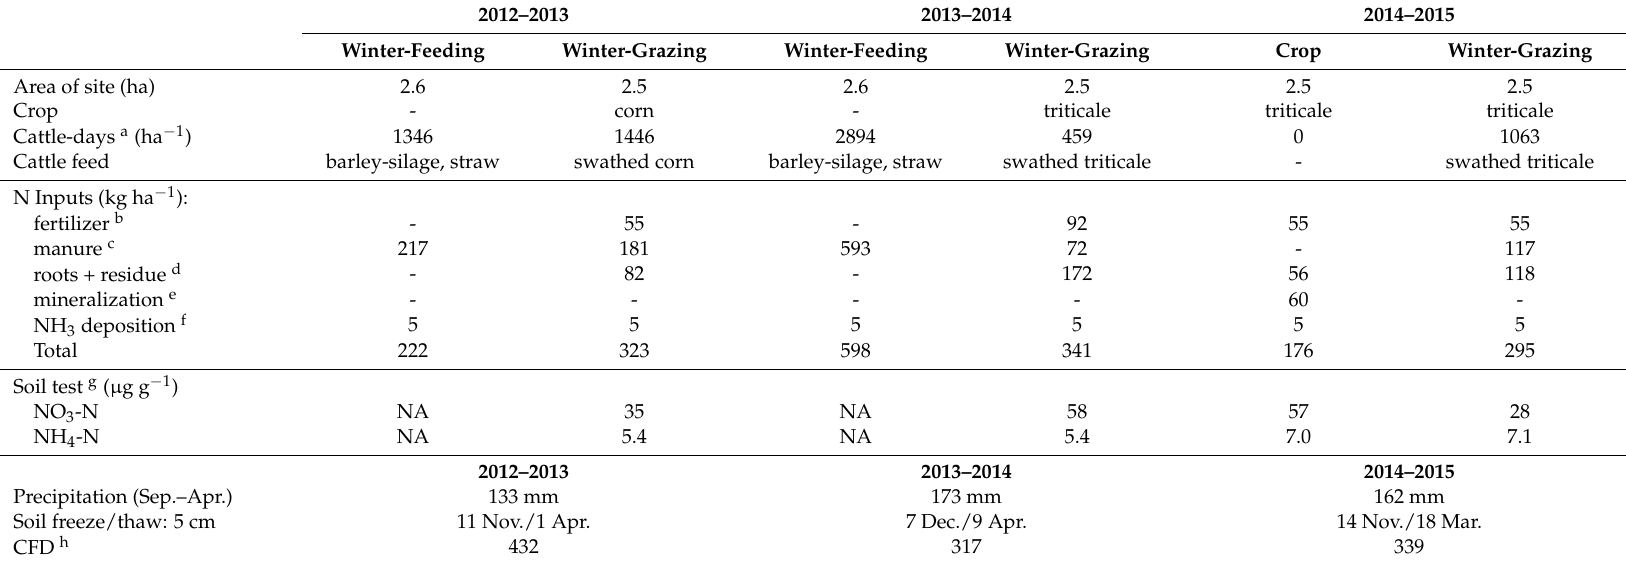
Table 1. Details of the winter-feeding, winter-grazing and crop